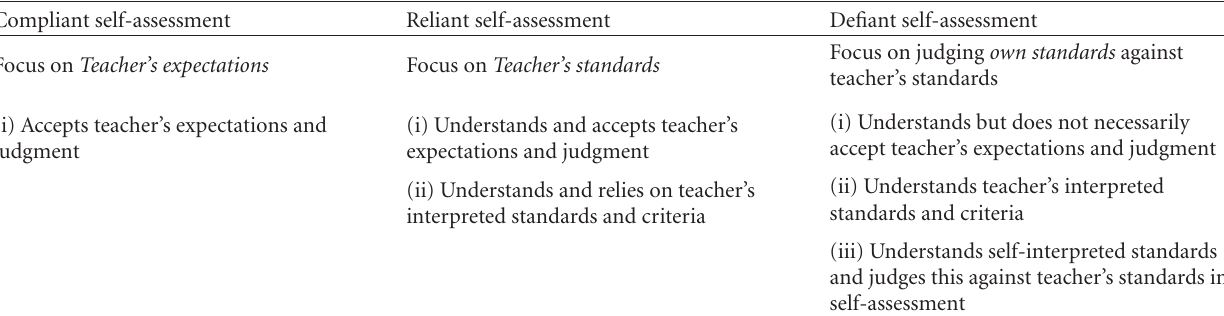
Table 1: The structure of students’ conceptions of self-assessment and standards.